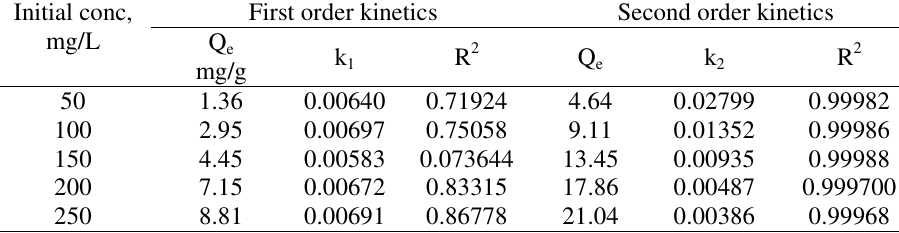
Table 3. Kinetic Parameters for the effect of initial sorbate